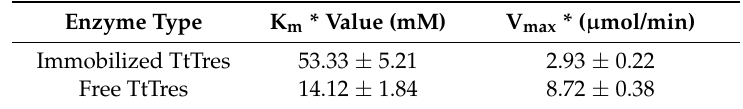
Table 3. The K m value and V max of immobilized and free TtTreS.